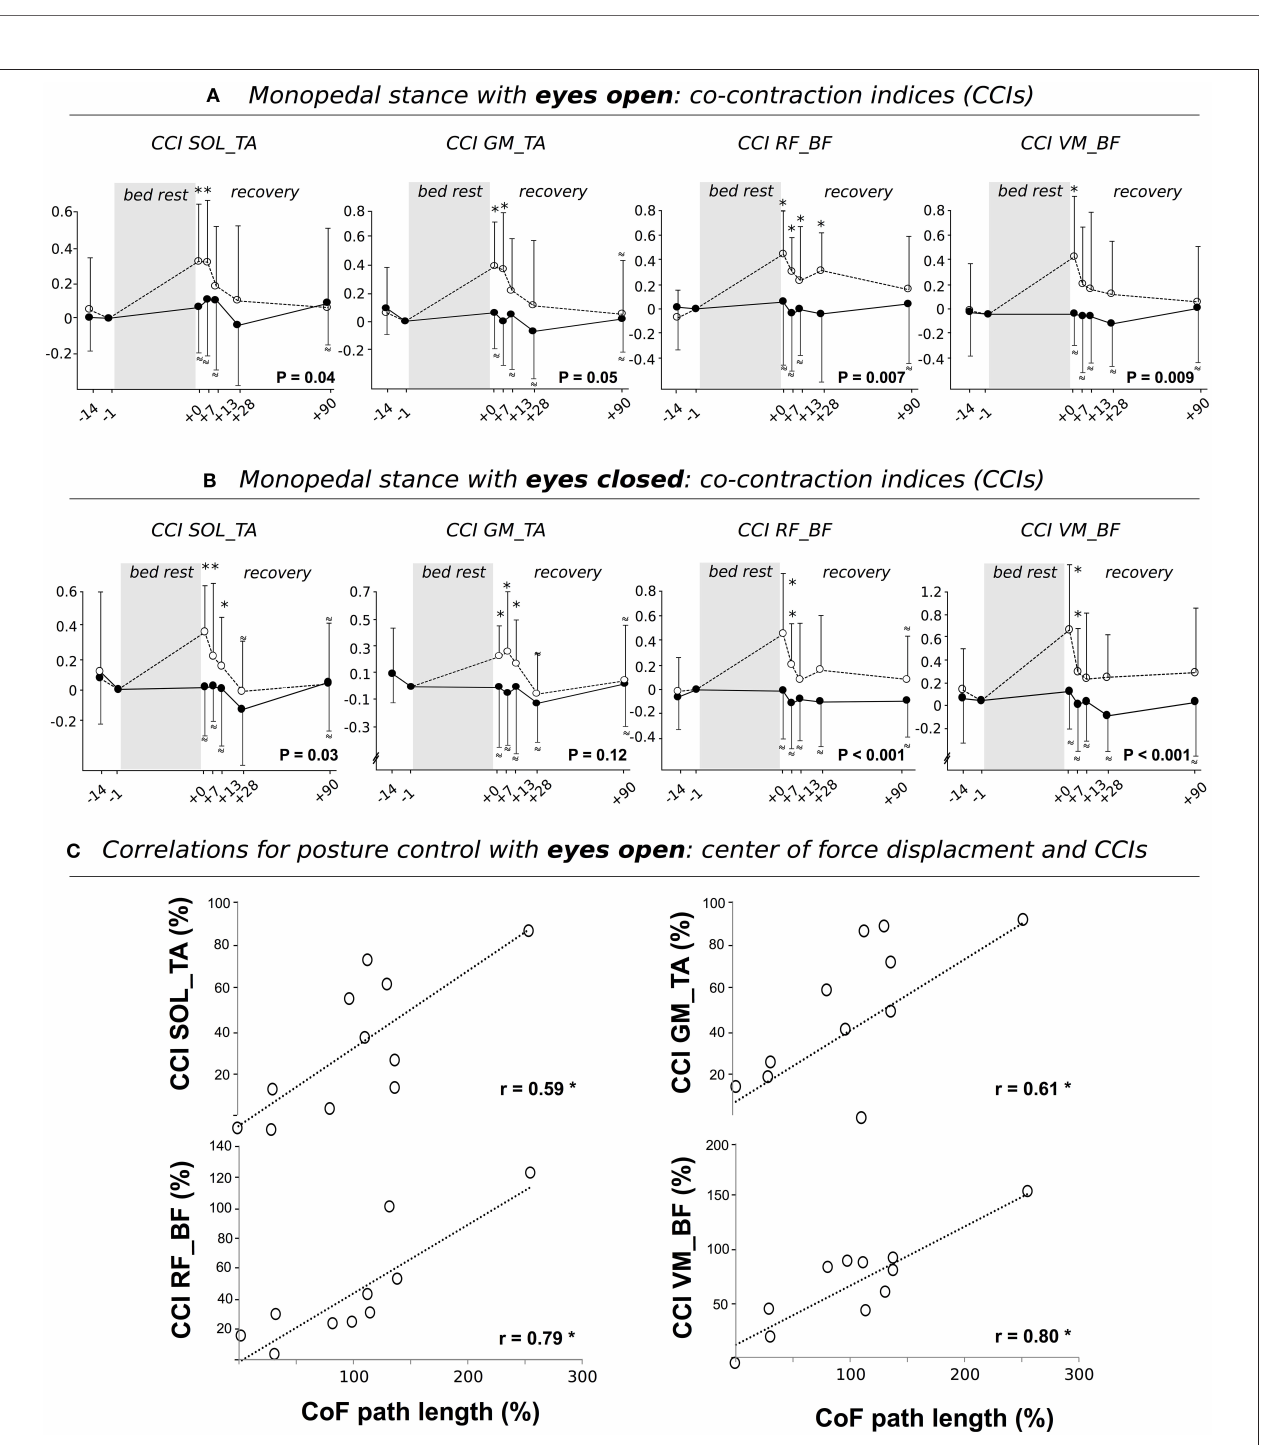
FIGURE 3 | Grand means of the co-contraction index (CCI) during posture control performed with (A) eyes open and (B) eyes closed for the CTRL (open circles) and JUMP group (full circles). Data is displayed for baseline measurements (BDC-14 and BDC-1) and the recovery period (R + 0, R + 7, R + 13, R + 28, and R + 90) after the 60 days of bed-rest. Results show changes in antagonistic muscle groups encompassing the ankle (m. soleus and tibialis (SOL_TA); m. gastrocnemius medialis (GM) and TA (GM_TA) and knee joint (m. rectus femoris and m. biceps femoris (RF_BF); m. vastus medialis and BF (VM_BF) indicating an increased CCI after bed-rest. P < 0.05 denotes a significant group*time interaction effect. * indicates a significant difference compared to baseline. If values were statistically non-inferior compared to baseline, they are marked with a ≈ symbol. (C) Pearson’s correlation coefficients among the variables center of force (CoF) path length (abscissa) with CCIs for differences between values obtained at R + 1 and BDC-1 for CTRL. Findings revealed positive correlations, indicating an interrelationship between the increased sway path and augmented antagonistic co-contraction. Values are means ± SE. *indicates significant findings ( P < 0.05).